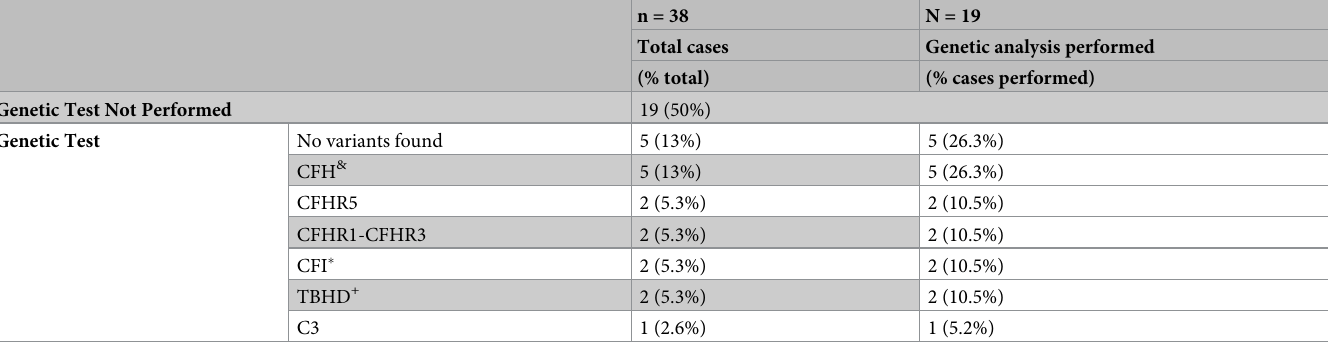
Table 2. Genetic variants of Brazilian aHUS cohort patients in renal